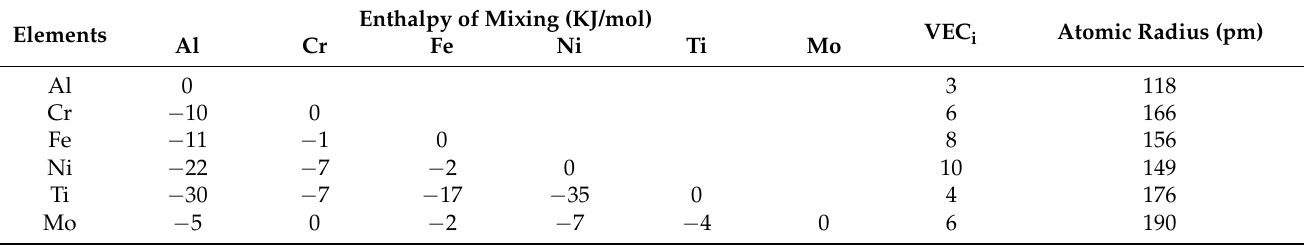
VEC i Atomic Radius (pm)